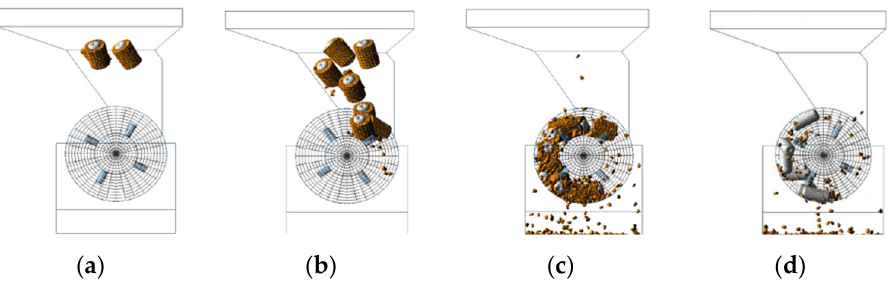
Figure 12. Simulation of a maize threshing process [100]. ( a ) Generation of corncob; ( b ) start of threshing; ( c ) during threshing; ( d ) end of threshing.